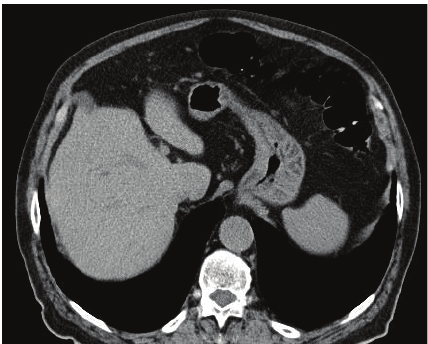
Figure 3: Transverse CT image showed the complete disappearance of gas in mesenteric vein and portal venous system, 24 hours after the